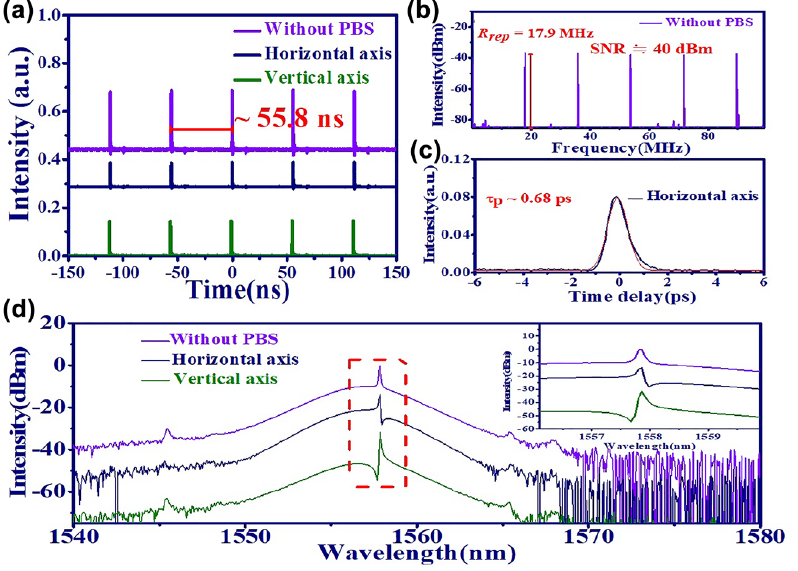
Figure 3: PL-GVLVS from EDFL based on GO/PVA film. (a) Time trace (without PBS: purple line, horizontal axis: navy line and vertical axis: green line), (b) RF spectrum without PBS, and (c) IAC trace on horizontal axis, and (d) optical spectrum and zoomed in spectrum of the Kelly sidebands (inset figure).